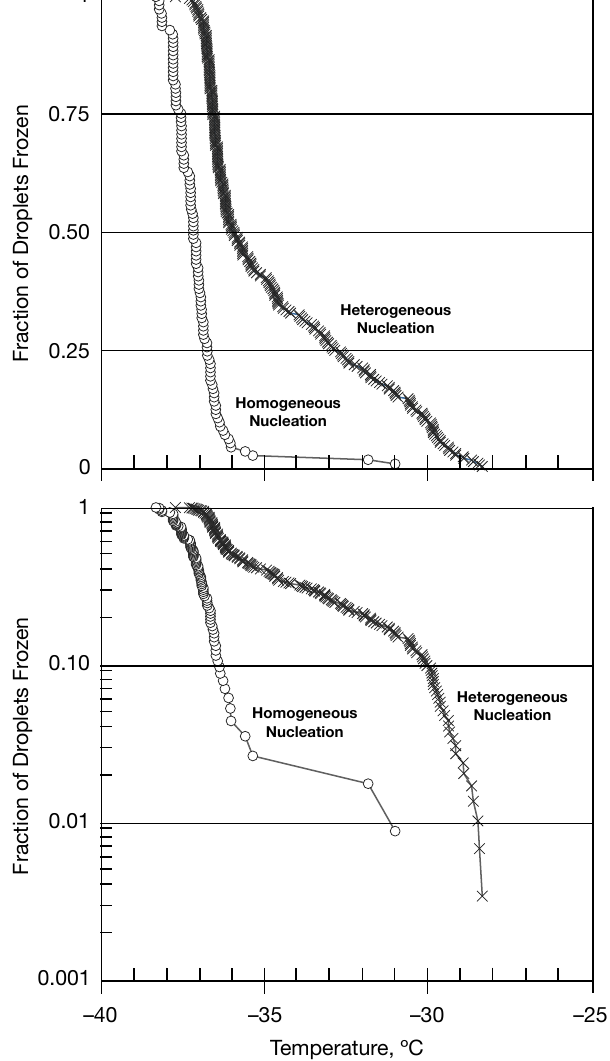
Fig. 6. Combined data for homogeneous nucleation experiments (113 freezing events) and heterogeneous nucleation experiments (292 freezing events). Both graphs show the same data but the bottom graph has been plotted on a logarithmic y-axis.